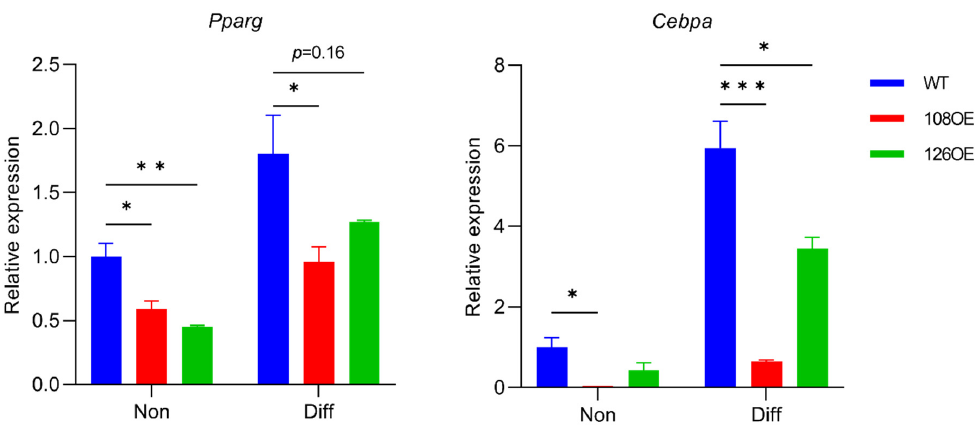
Figure 8. Expression of adipogenic genes Pparg and Cebpa was reduced in 3T3-L1 adipocytes overex- pressing Tas2r108 (108OE) or Tas2r126 (126OE). Pparg and Cebpa expression before (Non) and after (Diff) induction of differentiation compared with their expression in non-differentiated wild-type (WT) cells. N = 3, * p < 0.05, ** p < 0.01, *** p < 0.001, Dunnett test.